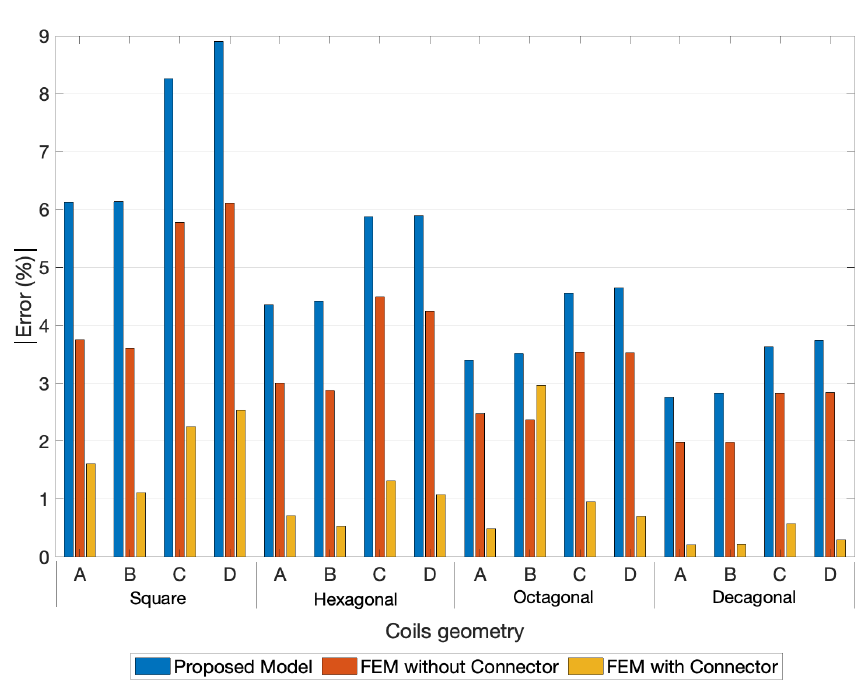
Figure 17. Relative errors module between the Experimental Measurements, the FEM simulations and the proposed model for the 1-layer coils. A- [ N = 10, w = 0.15 mm, and s = 0.15 mm ] ; B- [ N = 10, w = 0.15 mm, and s = 0.20 mm ] ; C- [ N = 8, w = 0.15 mm, and s = 0.15 mm ] ;